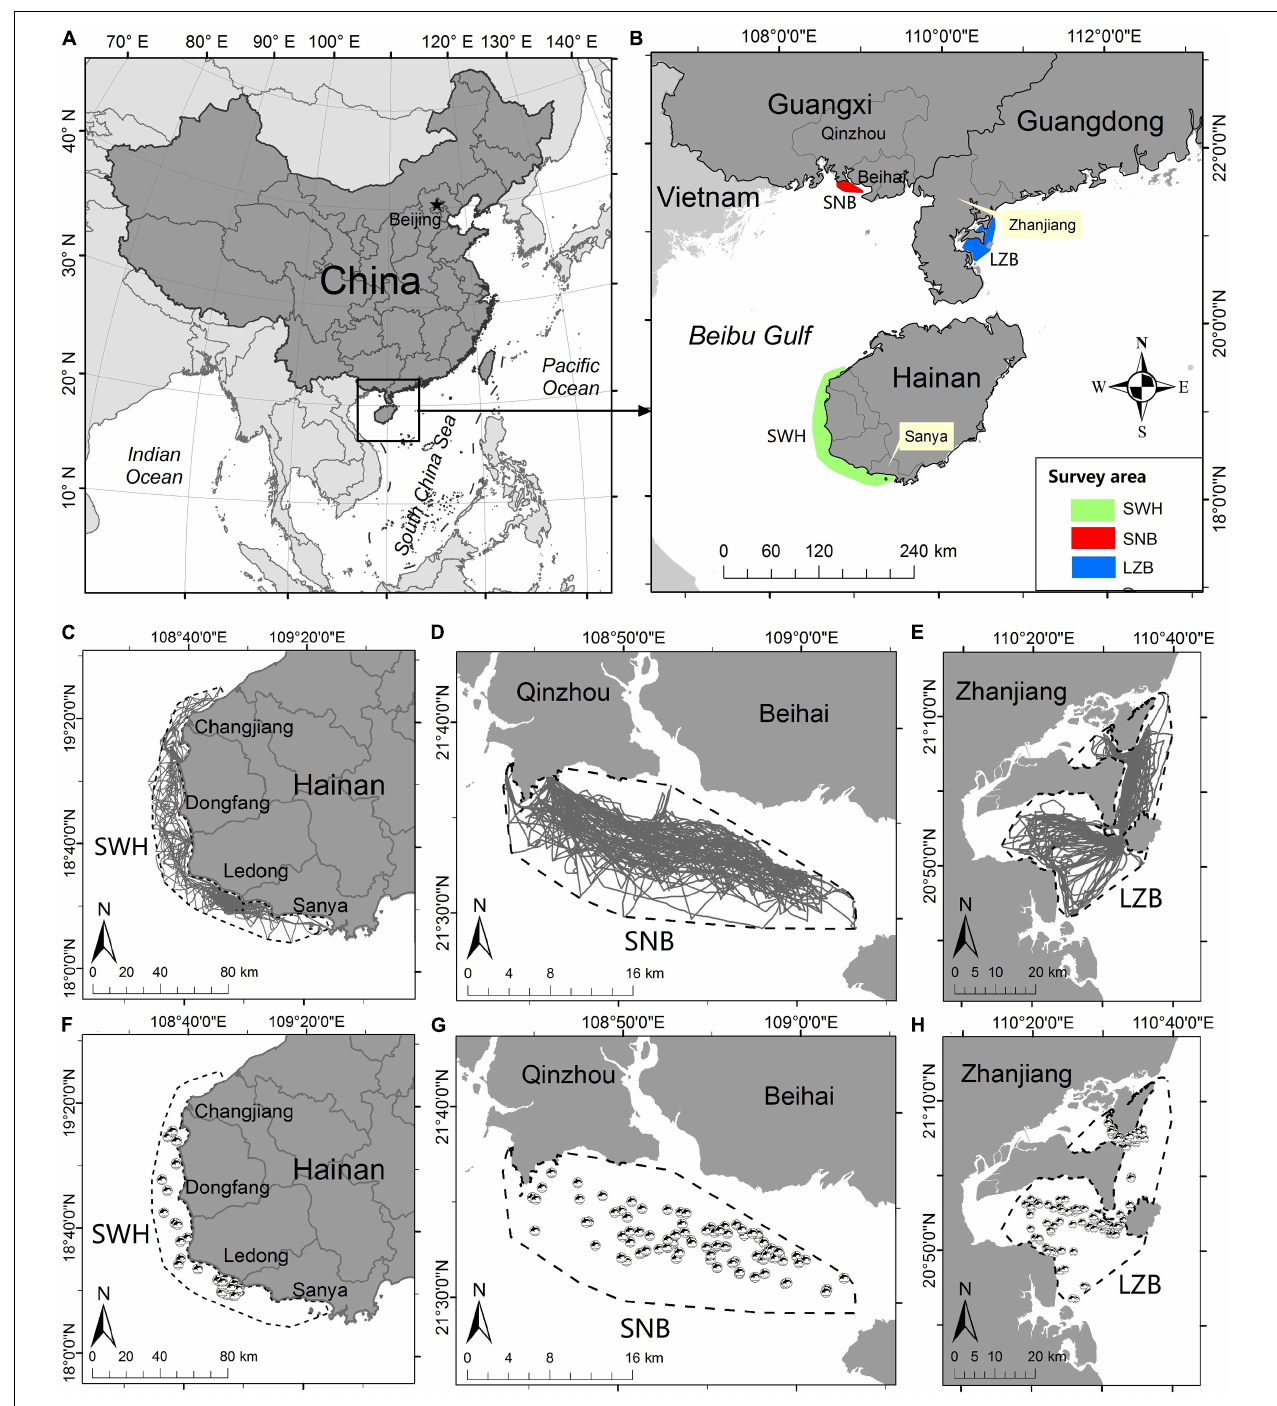
FIGURE 1 | Map of the study area: (A) the northern section of South China Sea, and (B) three sampling regions, i.e., the waters southwest off Hainan Island (SWH), Sanniang Bay (SNB), and Leizhou Bay (LZB). (C-E) Boat-based survey routes and (F-H) sighting locations of Indo-Pacific humpback dolphins ( Sousa chinensis ) achieved in each sampling